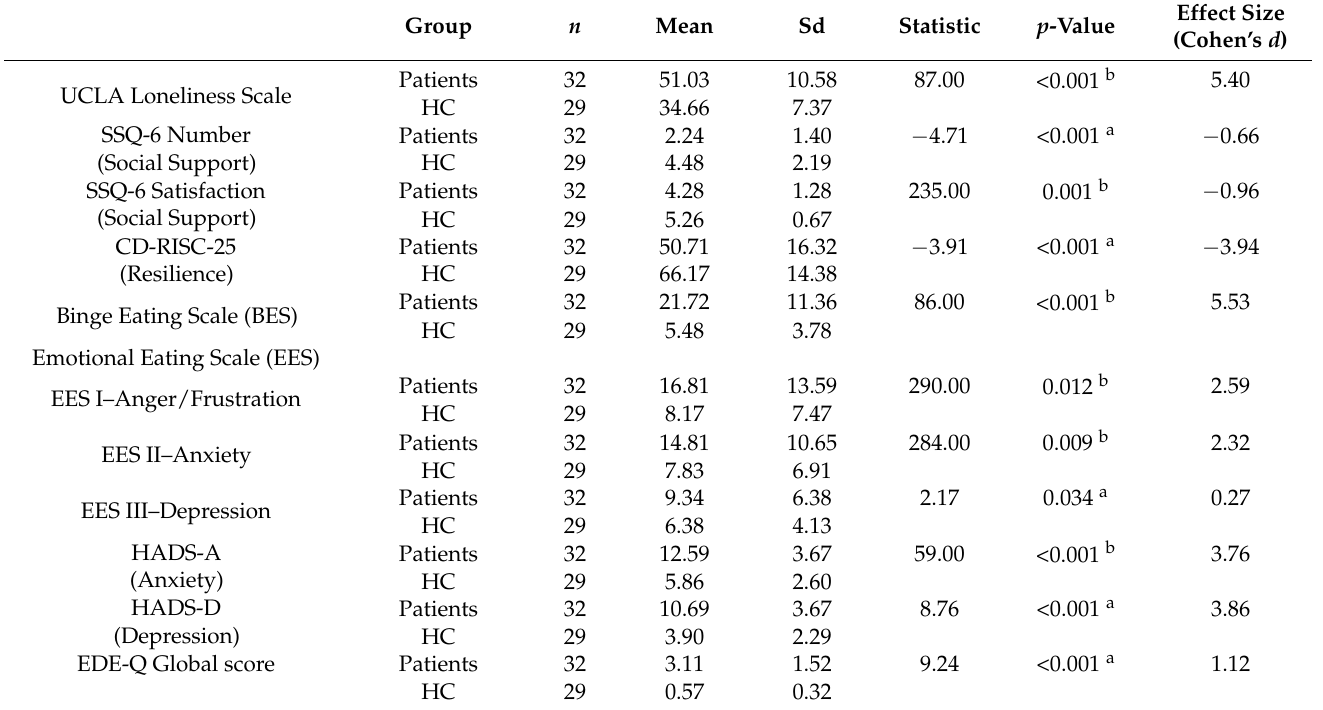
Table 2. Comparisons between ED patients and HC for the variables: loneliness, social support, resilience, binge eating, emotional eating, anxiety, depression, and ED